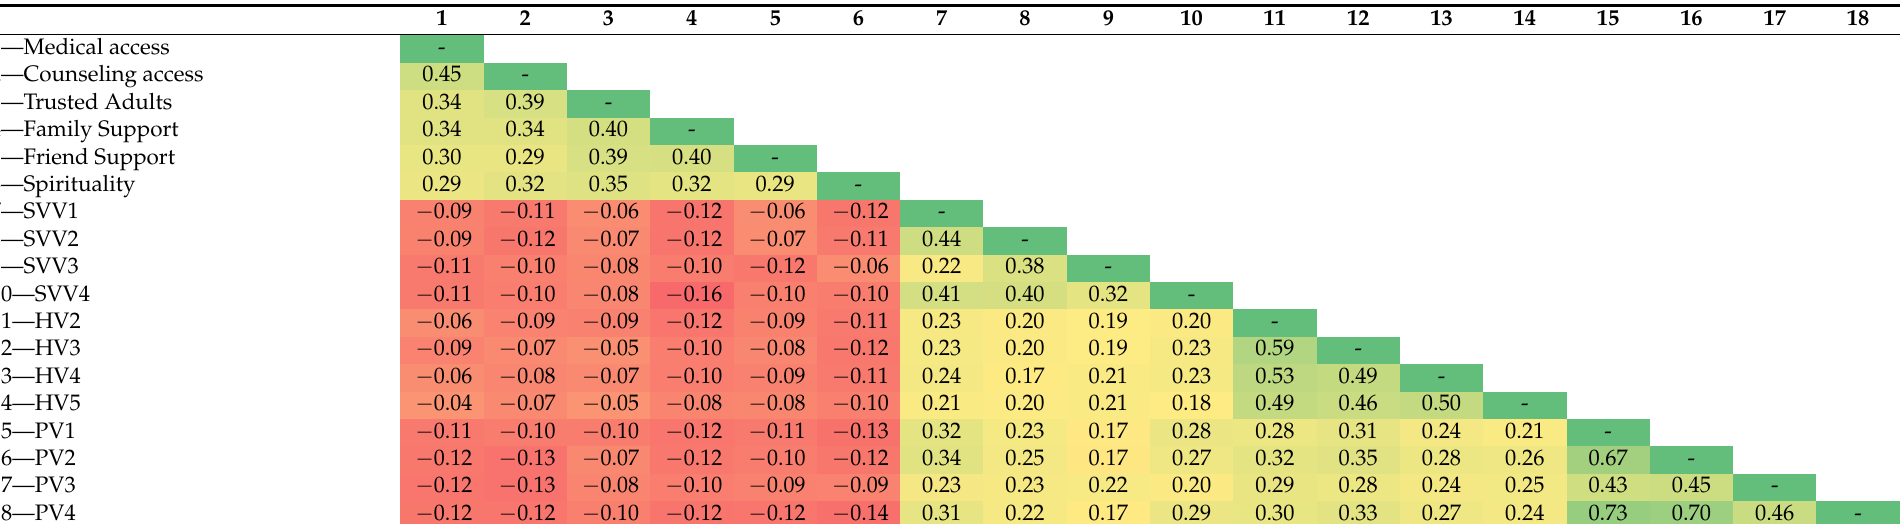
Table 2. Bivariate Correlations.